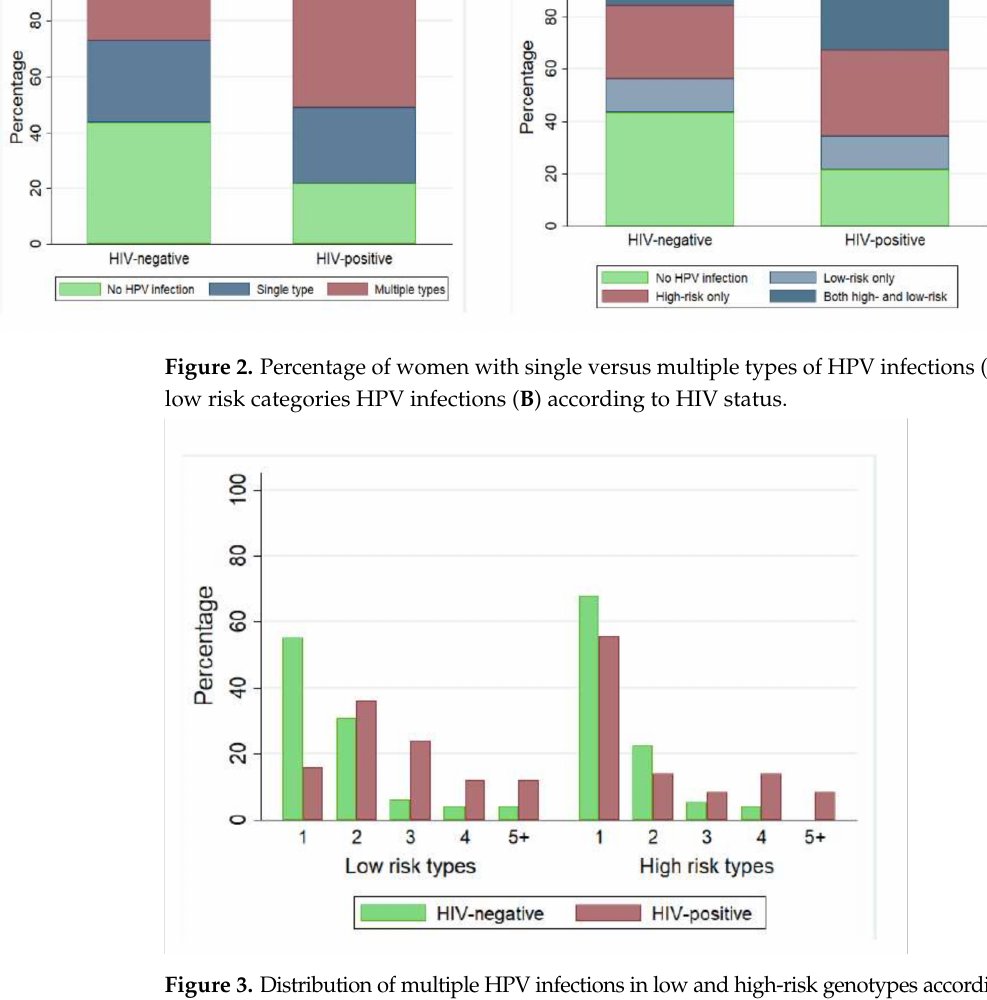
Figure 3. Distribution of multiple HPV infections in low and high-risk genotypes according to HIV